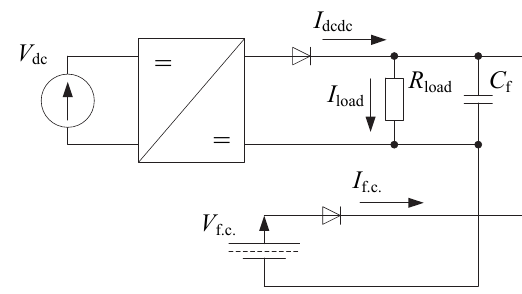
Fig. 8. The simplified principal scheme of the experiment.